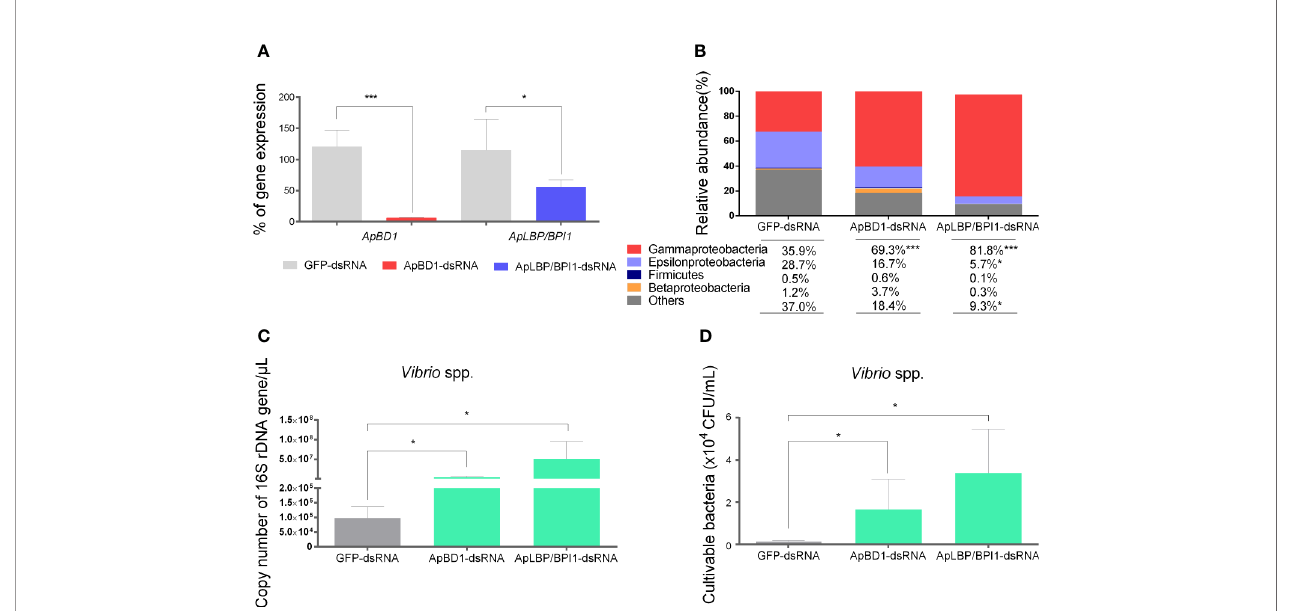
FIGURE 5 | Effect of the silencing of ApBD1 and ApLBP/BPI1 expression in scallop by RNAi on the relative abundances of target bacterial groups. (A) Transcript expression of ApBD1 and ApLBP/BPI1 in scallop hemocytes injected with Ap BD1-dsRNA (red bar) and Ap LBP/BPI1dsRNA (blue bar) compared to GFP-dsRNA (gray bar), considered as control of speci fi c gene silencing. Values are represented as the mean ± SE, considering the gene expression in GFP-dsRNA-injected animals as 100%. (B) Relative abundances of target bacterial groups present in the hemolymph of dsRNA injected scallops determined by qPCR and absolute quanti fi cation. (C) Number of total copies of speci fi c bacterial 16S rDNA gene for Vibrio spp. present in dsRNA injected scallops. Values are represented as the mean ± SE and asterisks indicate signi fi cant differences compared with GFP-dsRNA-injected scallops (* P < 0.05, *** P < 0.005). (D) cultivable Vibrio spp. present in hemolymph from dsRNA injected scallops. Values are represented as the mean number of colony forming units/ml of hemolymph ±